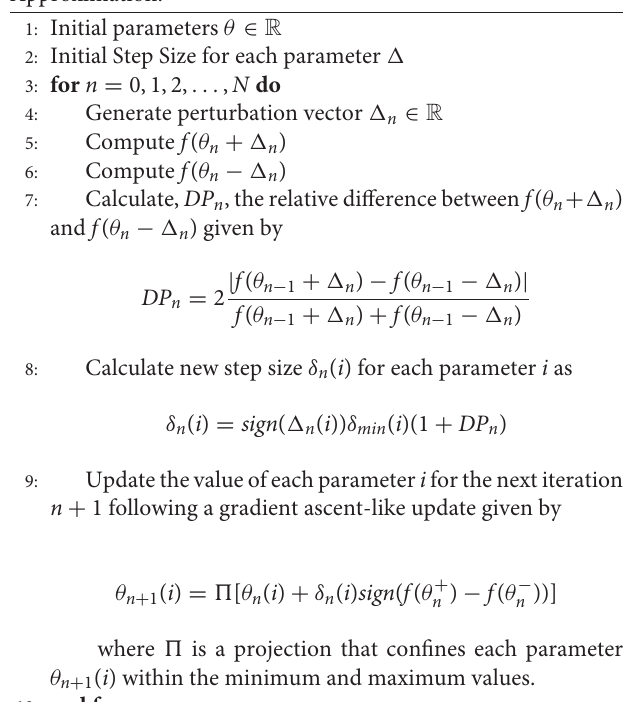
Algorithm 1 : Modified Simultaneous Perturbation Stochastic